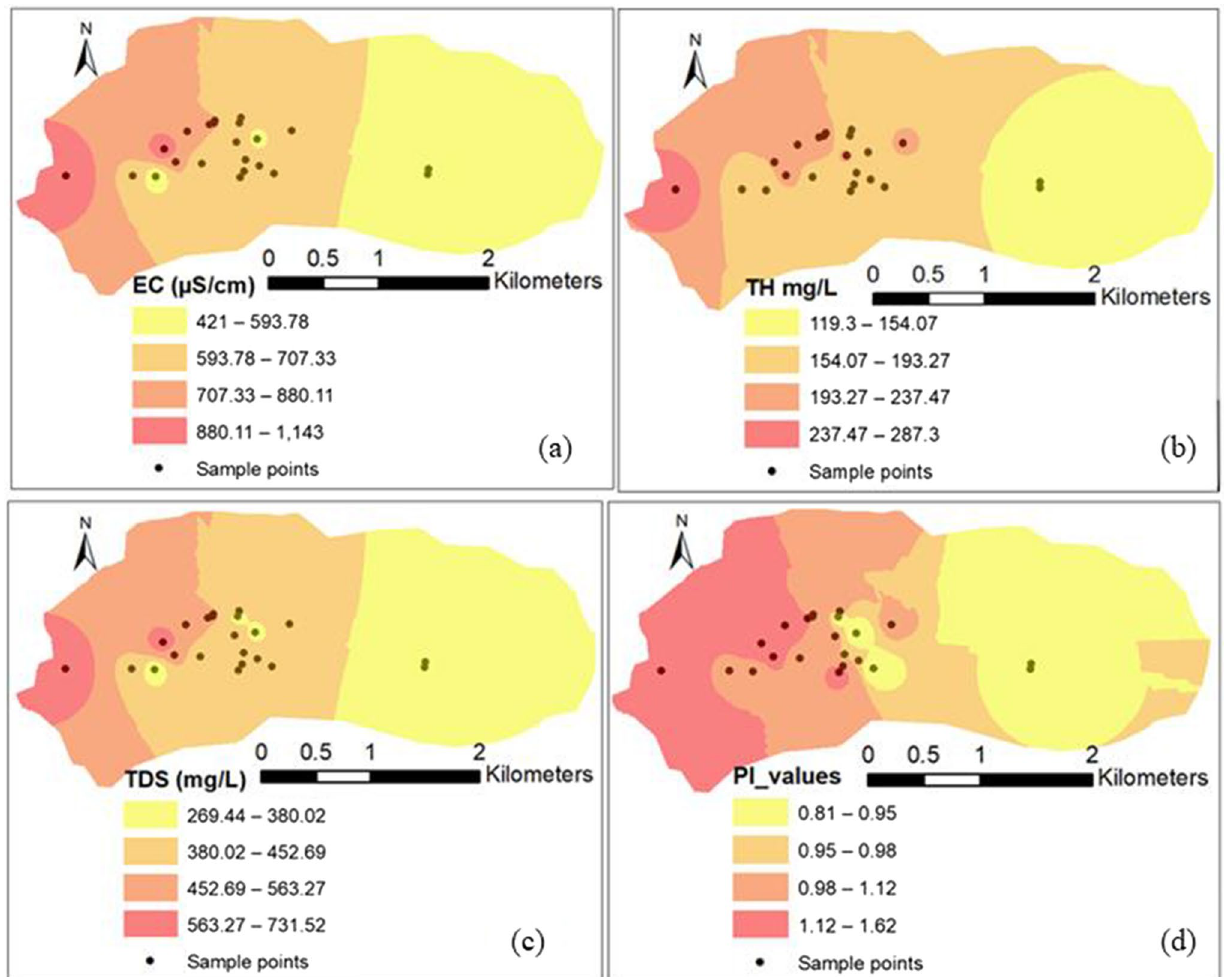
Fig. 2 Spatial distribution for drinking water quality classification based on weighted overlay model for: a EC, b total hardness (TH), c TDS and d pollution index